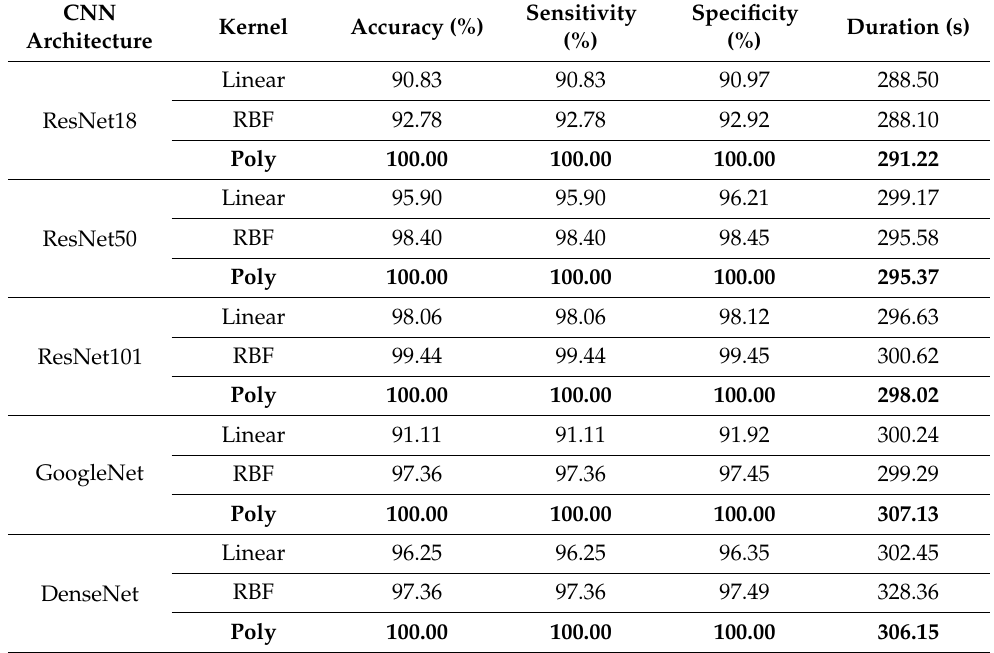
Table 2. Results of Experiment on Two-Class DRIVE